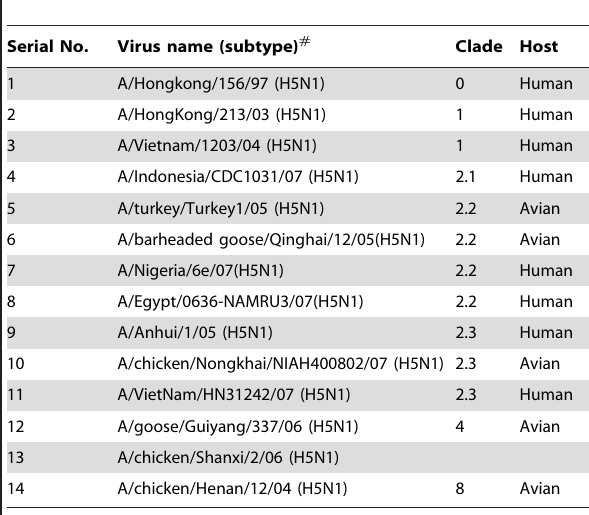
Table 1. Reassortant influenza A viruses generated by reverse genetics.